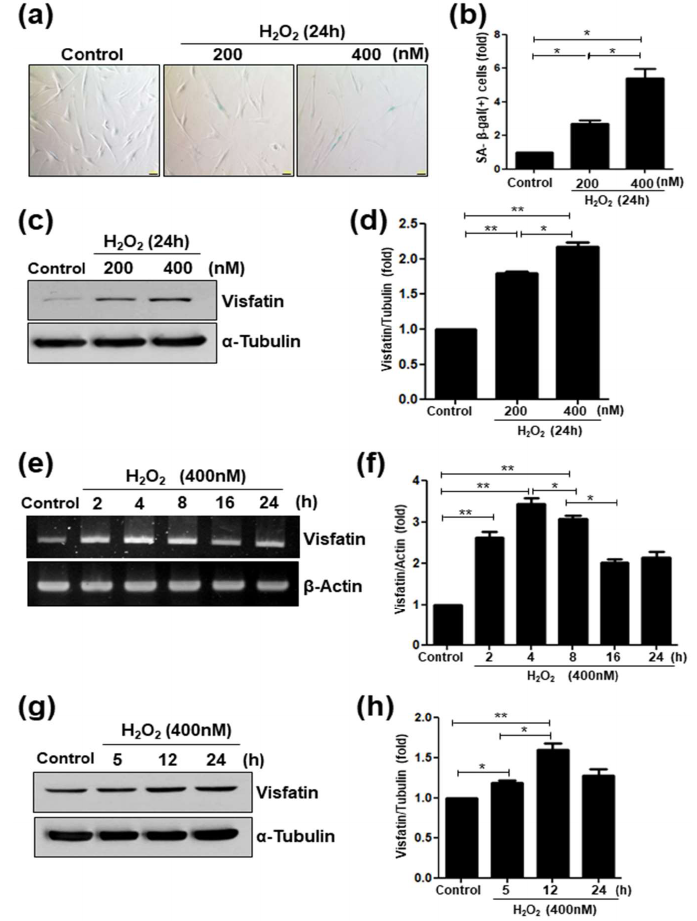
Figure 2. Upregulation of visfatin in H 2 O 2 -induced senescence of human dental pulp cells (hDPCs). ( a – d ) hDPCs were stimulated with different concentrations of H 2 O 2 (0, 200, and 400 nM) for 24 h. ( a ) The cells were stained for the detection of the activity of senescence-associated (SA)-β-galactosidase. Scale bar: 200 μm. ( b ) Quantitative results for the percentage of SA-β-galactosidase positively stained cells. ( c ) Cells were treated with H 2 O 2 (200 and 400 nM) for 24 h. Cell lysates were subjected to Western blotting for detecting the levels of visfatin or α-Tubulin used as the loading control. ( d ) Relative visfatin protein levels normalized with α-Tubulin protein levels. (e-h) Cells were incubated with H 2 O 2 (400 nM) for different time periods (0–24 h). ( e ) Cell lysates were subjected to RT-PCR for determining visfatin mRNA expression. β-Actin was used as an internal control. ( f ) Relative visfatin mRNA levels normalized with the levels of β-Actin mRNA. ( g ) Cell lysates were subjected to Western blotting to detect the levels of visfatin protein. α -Tubulin was used as the loading control. ( h ) Relative visfatin protein levels were normalized with the levels of α -Tubulin protein. * p < 0.1, ** p <